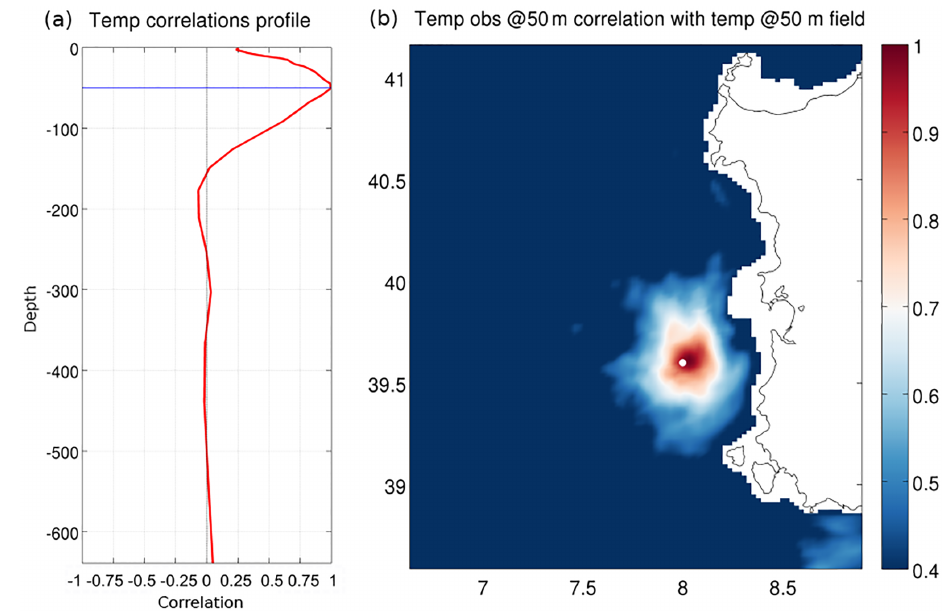
Figure 14. EnOI temperature ensemble correlations for a temperature observation within the REP14-MED domain at 50m depth (position indicated by the white dot on panel b ). (a) Correlations along the vertical. (b) Horizontal correlations at 50m